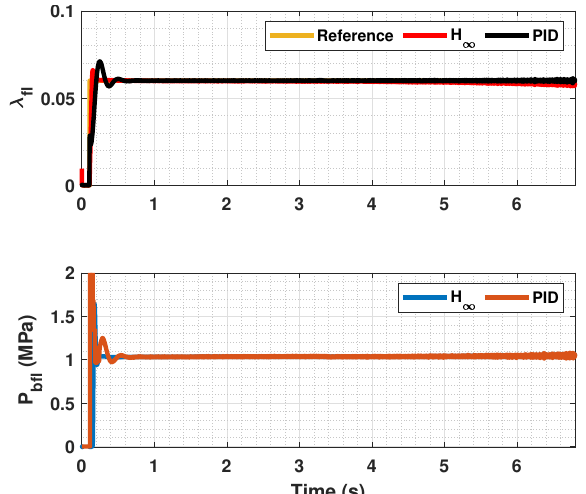
Figure 11. Front wheels tire slip, reference tire slip and brake pressure for µ max =